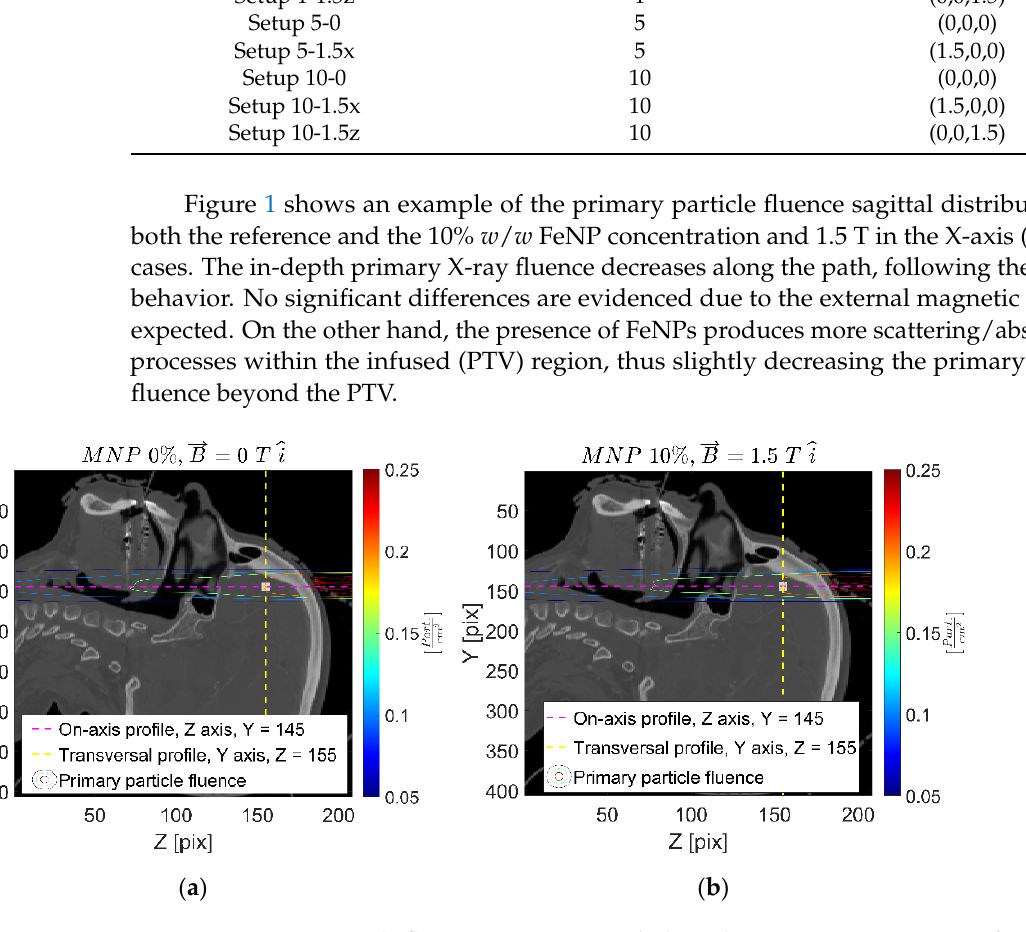
Figure 1. Primary particle fluence map on sagittal plane showing magnetic FeNP-infused target volume and vertical/horizontal profiles (light-/dark-colored dash lines) along with level contours at 25% (blue), 50% (green), and 75% (orange) of the maximum absorbed dose for the reference ( a ) and 10% w / w FeNP with 1.5 T (10-1.5x) ( b ) configurations. Optical (central) axis of the primary X-ray beam corresponds to the dark horizontal dash line.